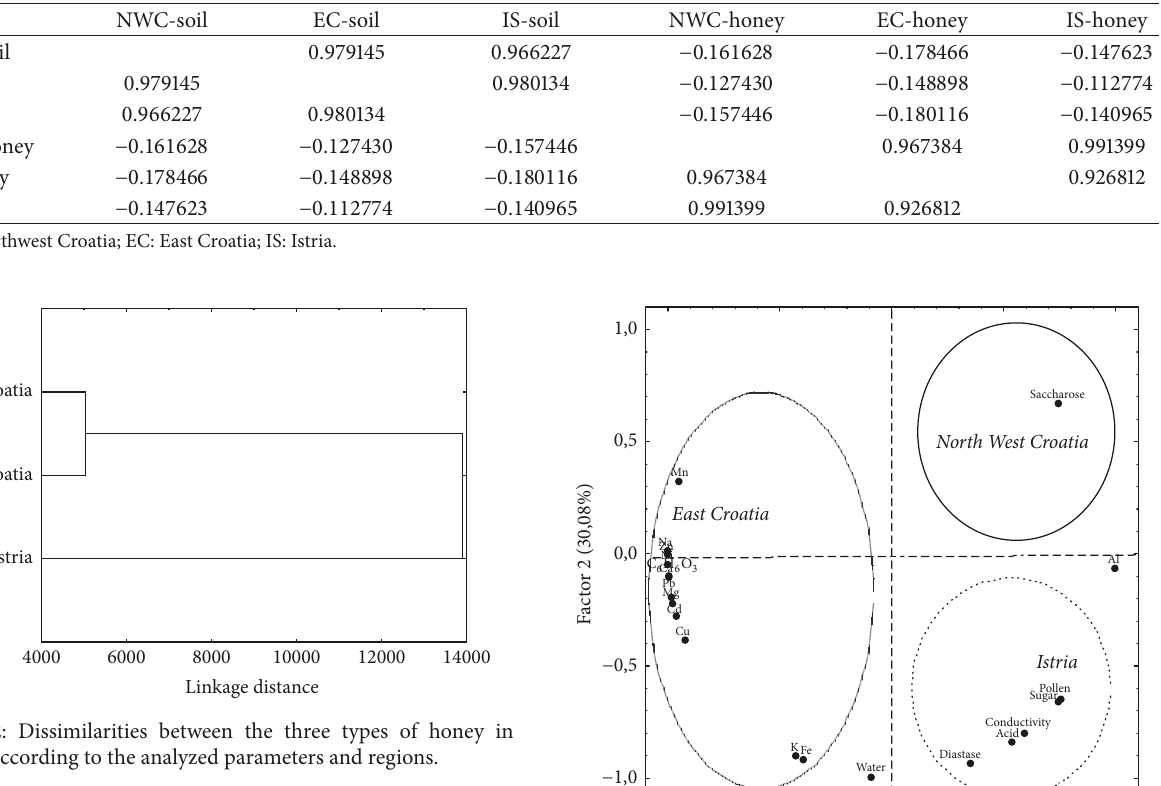
Table 5: An overview of the correlation coefficient between the concentrations of minerals (elements) in acacia honey and soil from three Croatian regions.